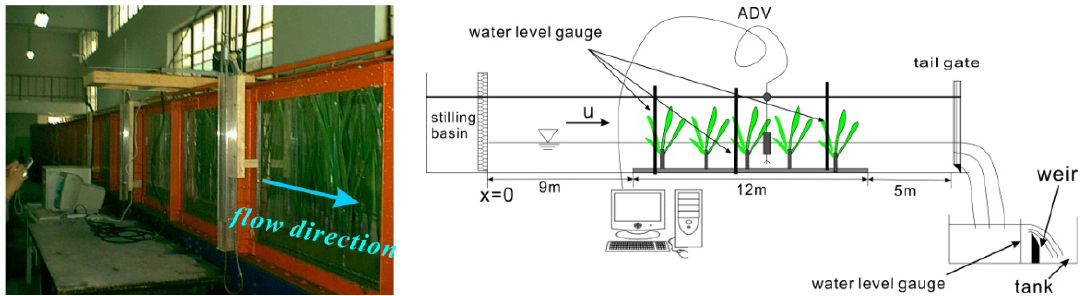
Figure 2. Schematic of experimental